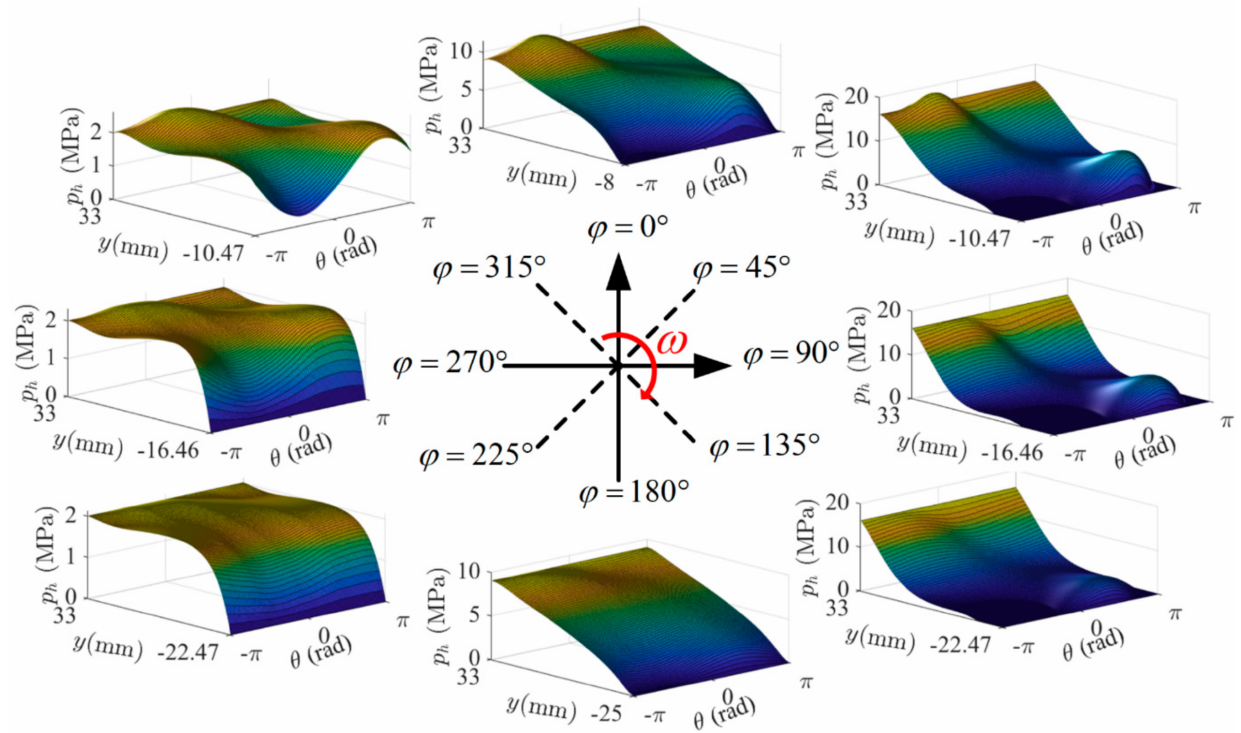
Figure 10. The oil film pressure distribution over 1 shaft